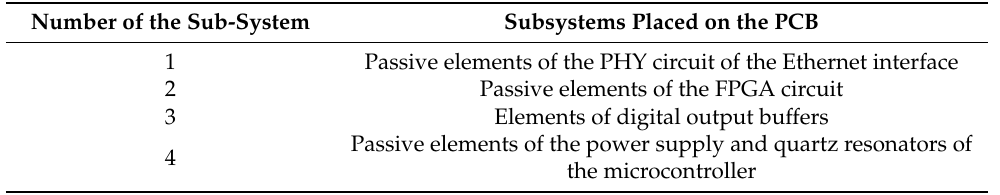
Table 4. Sub-systems placed on the PCB (Figure